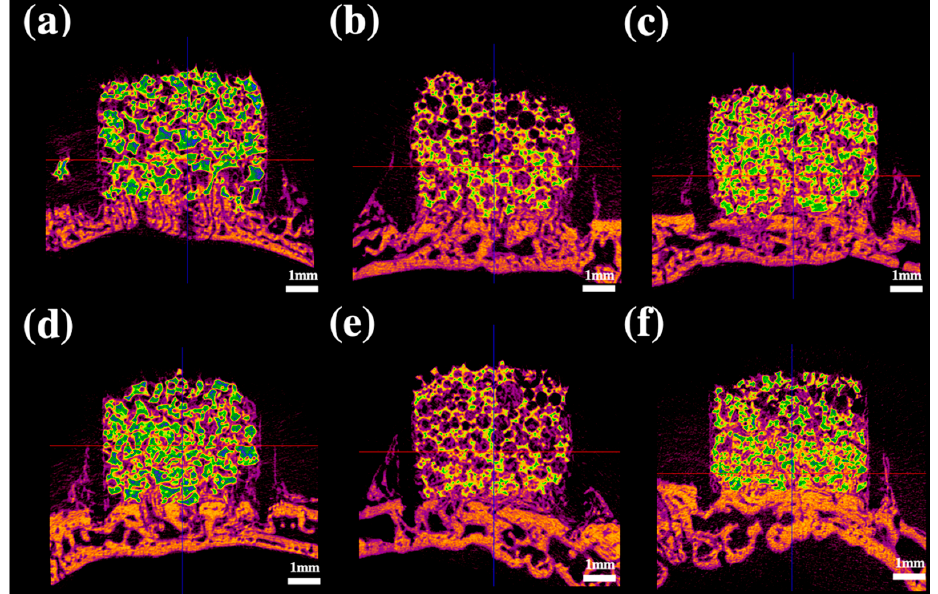
Figure 2. Radiological analysis after 3 weeks. ( a ) BCP powder containing 0.1 mg/mL rhBMP-2; ( b ) BCP block containing 0.1 mg/mL rhBMP-2; ( c ) collagen-added BCP containing 0.1 mg/mL